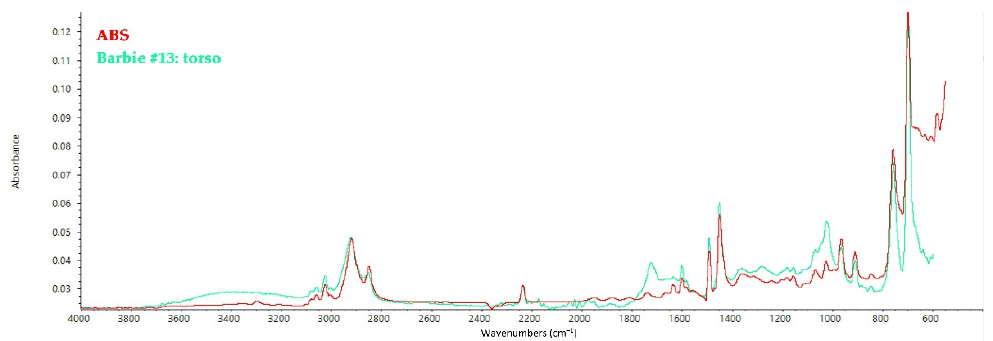
Figure 5. FT-IR ATR spectrum collected on the torso of Barbie #13 and shown as a model spectrum of ABS elements in all the other dolls, with the reference spectrum of ABS.